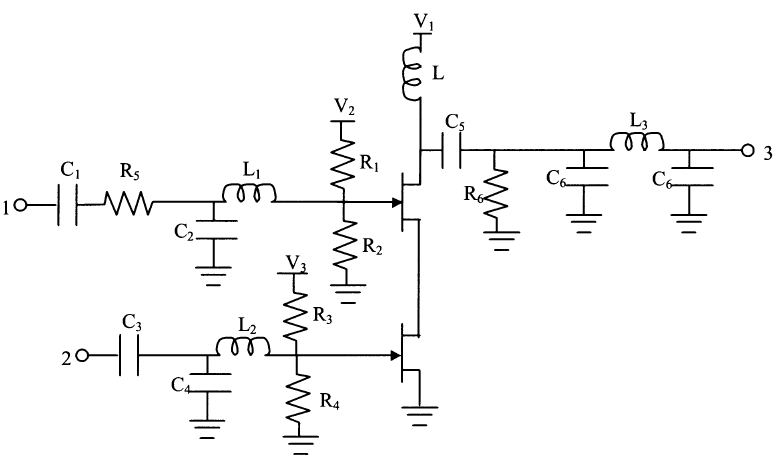
FIGURE 9 DC biased and matched